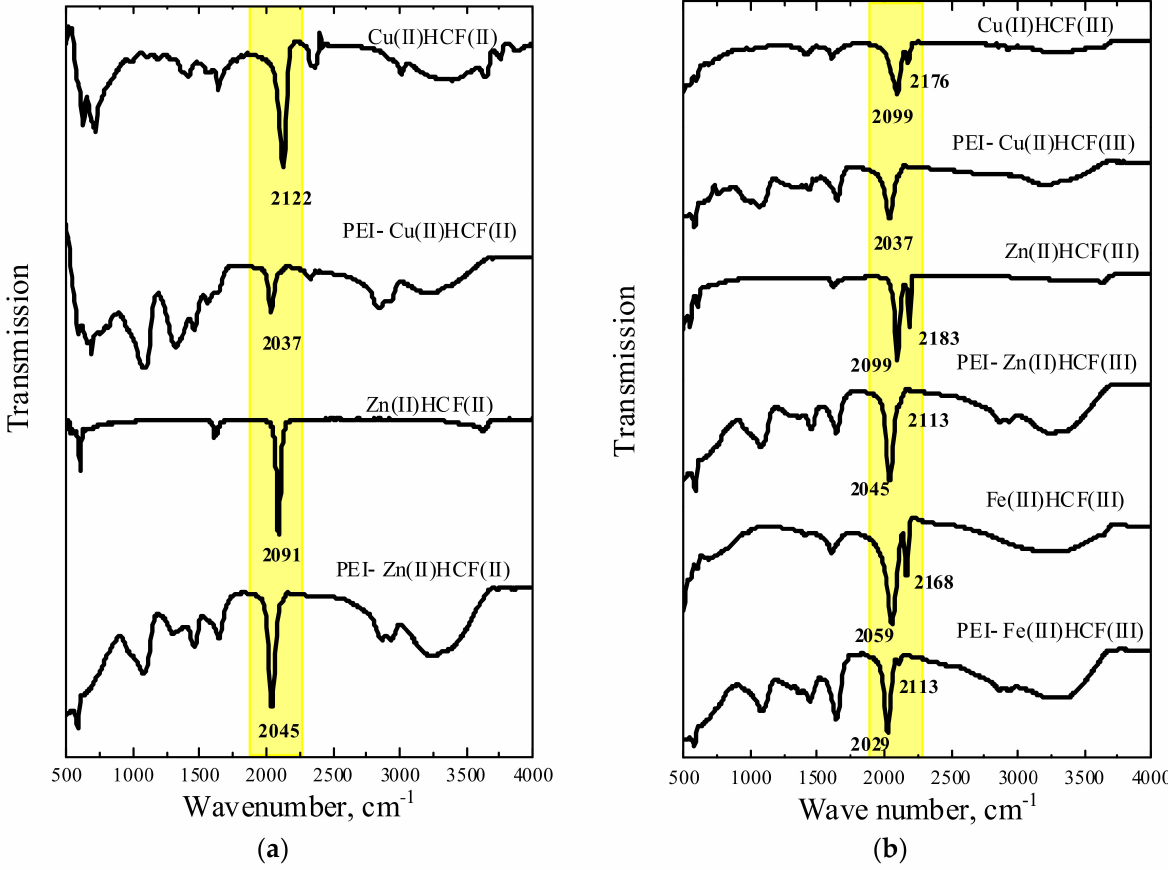
Figure 2. FT-IR spectra of crystalline hexacyanoferrates (HCF) and related PEI–HCF hybrids obtained using K 4 [Fe II (CN) 6 ] ( a ) and K 3 [Fe III (CN) 6 ] ( b ) as